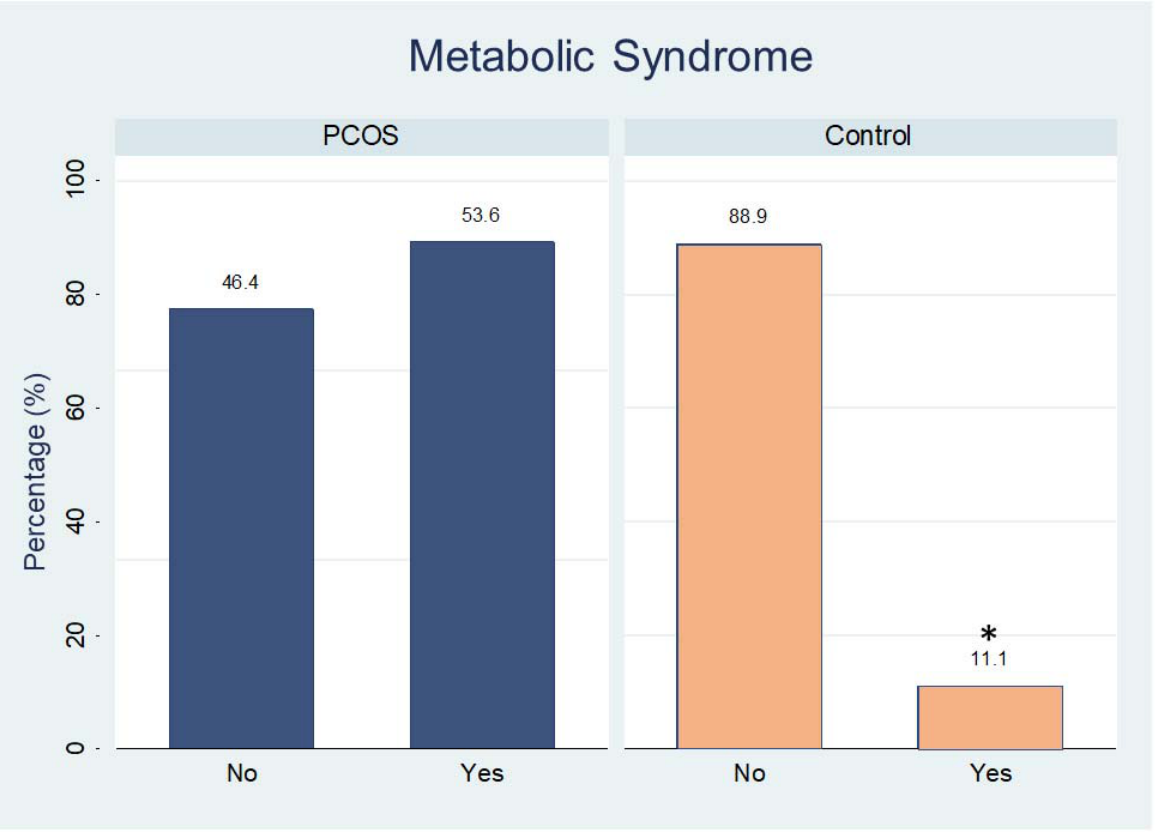
Figure 3. Percentage of participants with (yes) or without (no) metabolic syndrome in both groups. * p < 0.01.